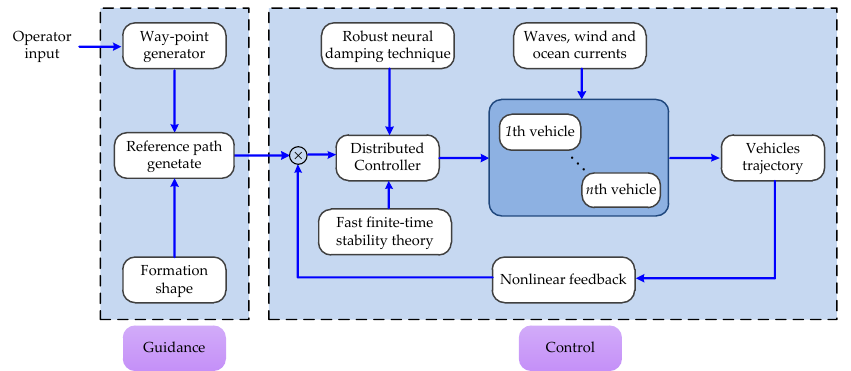
Figure 1. Conceptual signal flow box diagram for guidance, and control .